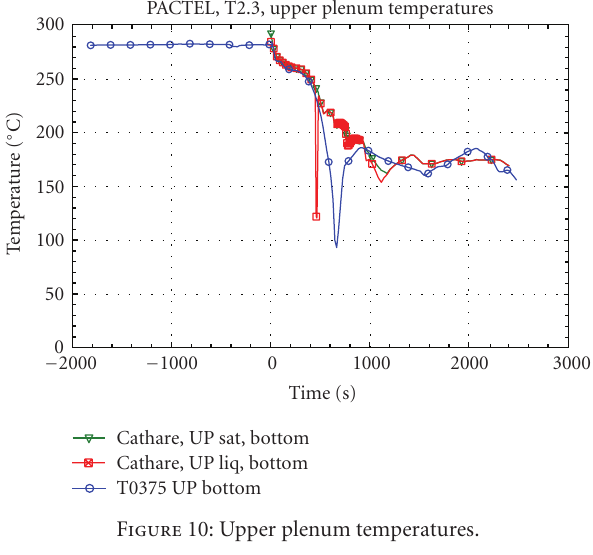
Figure 12: ECCS mass flows.